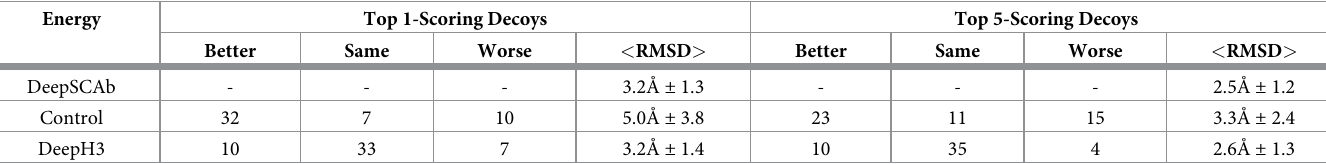
Table 1. Decoy discrimination compared to